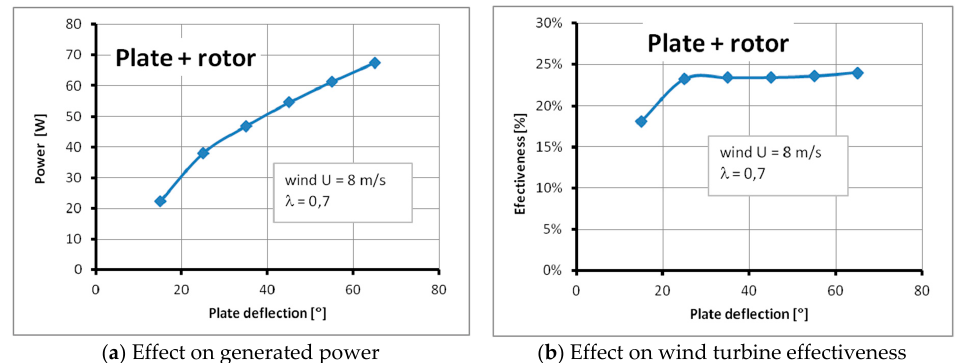
Figure 9. Effect of turbine opening. Figure 9. E ff ect of turbine opening.